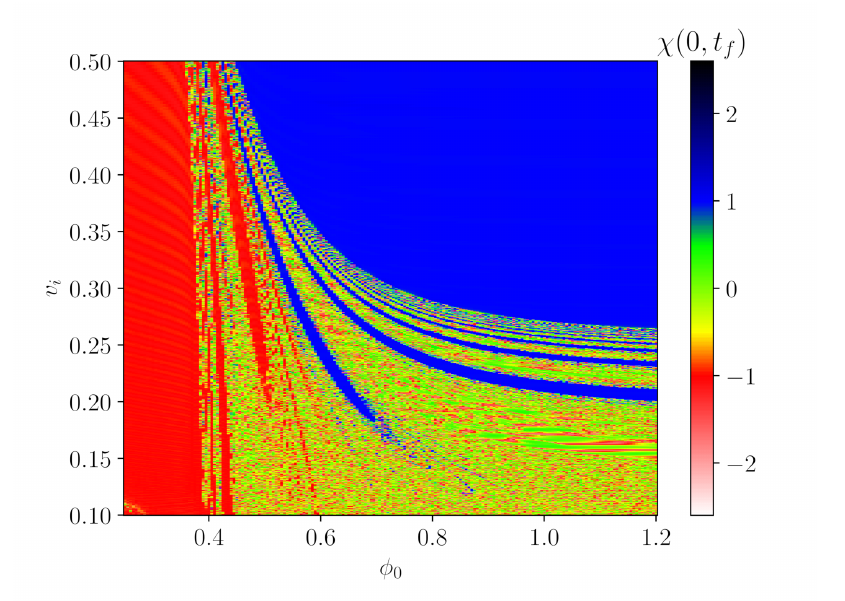
Figure 2 . Final value of the scalar field at the center of the collision as a function of φ 0 and v . We consider the attractive case where the fermions start at the zero